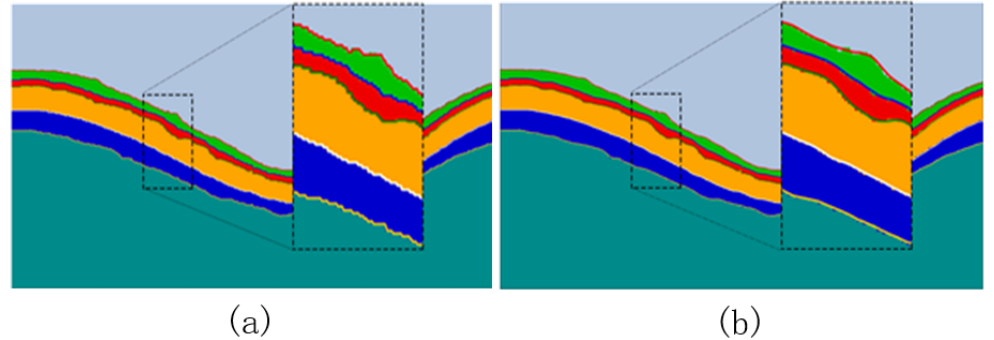
Figure 6. ( a ) Pixel-level prediction map extracted by Canny algorithm; ( b ) effect of the Savitzky–Golay filter algorithm to fit the